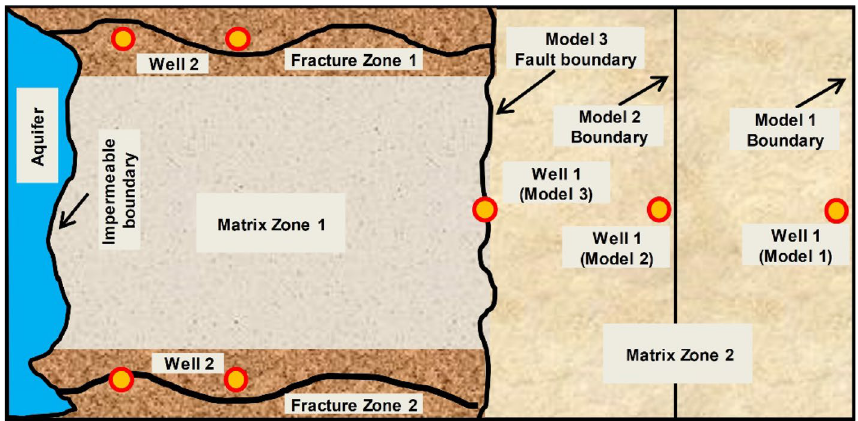
Figure 2. Multi-well joint water-control geological model for fractured water drive gas reservoirs (three geological models).